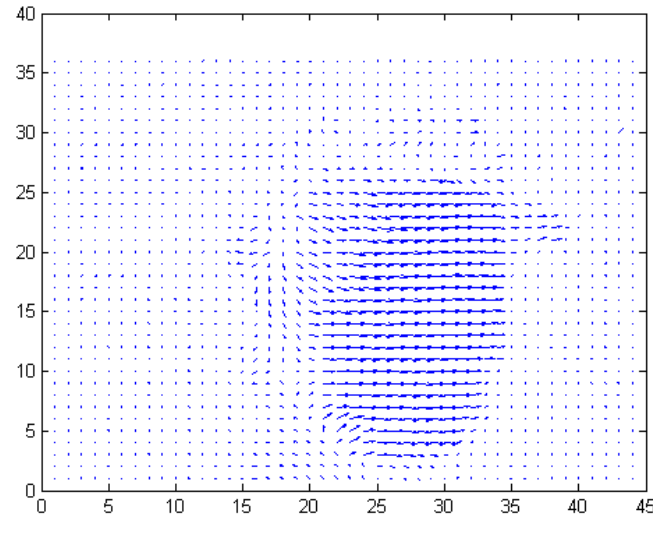
Figure 4. Effective motion vector